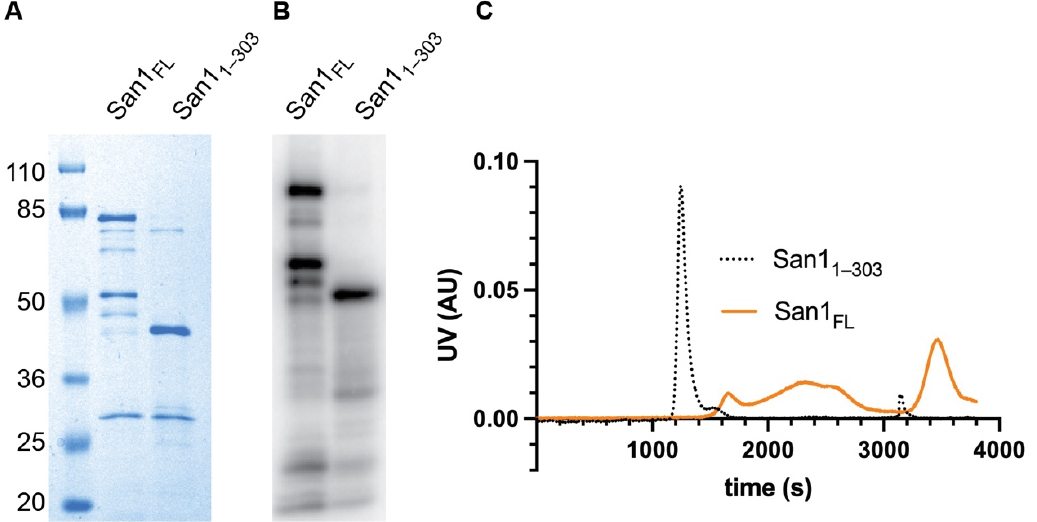
Figure 1. C-terminal truncation of San1 at the RING domain, San1 1–303 , results in greater purity and homogeneity compared with full-length. ( A ) Coomassie blue-stained SDS-PAGE gel showing the relative purities of full-length San1 versus San1 1–303 . Identical amounts of protein were loaded to each lane according to their optical densities at 280 nanometers. Notice that both proteins migrate significantly slower than their predicted molecular weights (full-length ~67.5 kDa and San1 1–303 ~35 kDa), likely due to a lower content of hydrophobic residues. ( B ) The proteins in ( A ) were radiolabeled with 32 P phosphate owing to the presence of a protein kinase A site at the N-terminus, followed by SDS-PAGE and detection by autoradiography. ( C ) Ultraviolet absorbance units (UV AU) comparing the migration of full-length San1 and San1 1–303 by gel filtration chromatography.